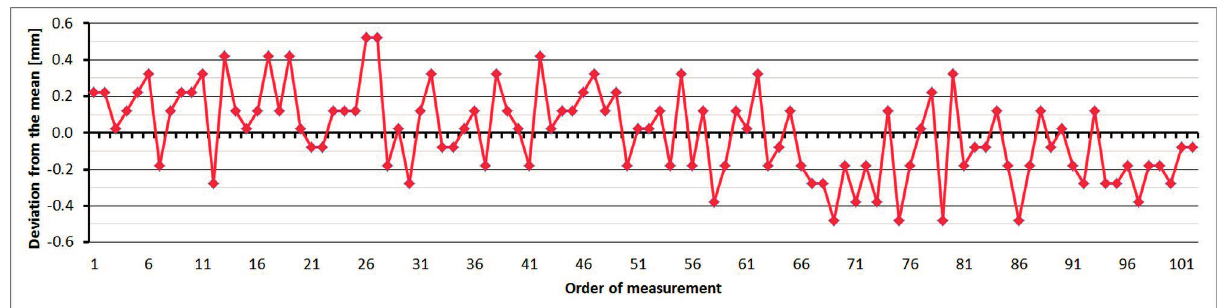
Figure 18. Trimble S8–Absolute errors in one epoch.